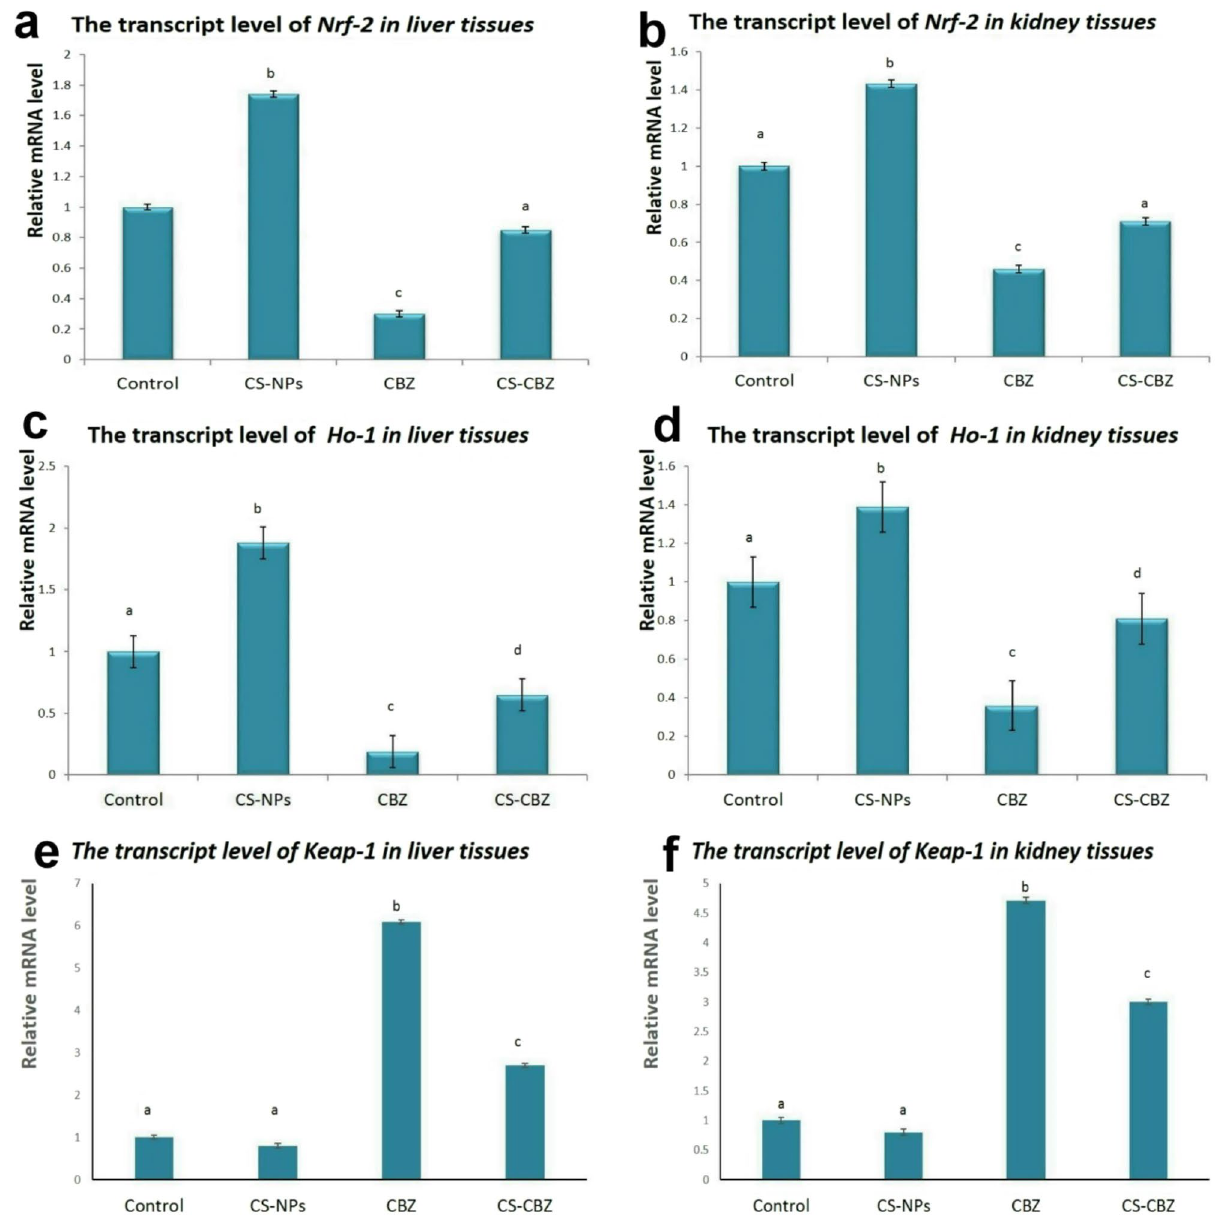
Figure 6. Bar charts representing; ( a ) Nrf2 transcript level in liver, ( b ) Nrf2 transcript level in kidneys, ( c ) HO-1 transcript level in liver, ( d ) HO-1 transcript level in kidneys, ( e ) Keap-1 transcript level in liver, ( f ) Keap-1 transcript level in kidneys. Values represented as Mean ± SD. Values with different letters means significant difference at P ≤ catalyzing the decomposition of H 2 O 239 , whereas the reduced glutathione (GSH) is required for several cell processes associated with abnormal changes in the maintenance and regulation of the thiol-redox status 40 . It exerts a potent antioxidant role through direct interaction with reactive oxygen species (ROS) or by operating as a cofactor for the peroxidase enzyme 41 . CBZ can induce the excessive generation of reactive oxygen and nitrogen species by altering the oxidants/antioxidants balance by promoting lipid peroxidation (LPO) and depleting both enzymatic and non-enzymatic cellular antioxidants leading to a condition of oxidative stress and cell death 42,43 . ROS overproduction initiates the processes of DNA and cell membrane damage via lipid peroxidation and protein degradation 44 . CBZ induced oxidative stress and can disturb various parts of cellular signaling and homeostasis through mediating redox signaling and depletion of antioxidant reservoirs 45 . Exogenous stimuli such as inflammatory cytokines increase intracellular ROS that contributes to the severity of pathological disorders 46 . One of the main proteins that control the redox signaling in mitochondrial oxidative phosphorylation is cytochrome c (Cc), the functions of which are regulated by the phosphorylation of several residues 47 . Under oxidative stress conditions,